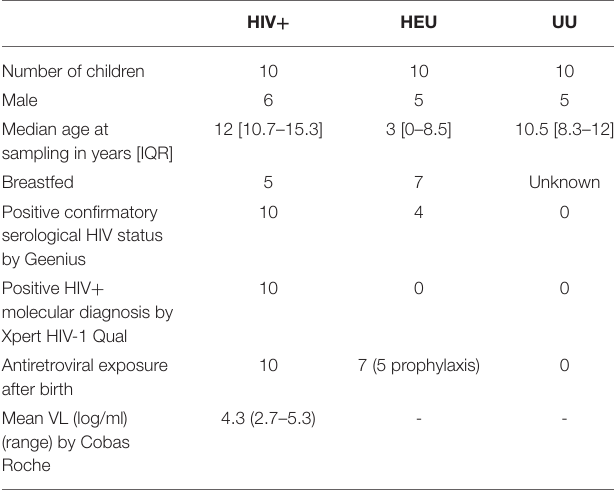
TABLE 1 | Main features of the study